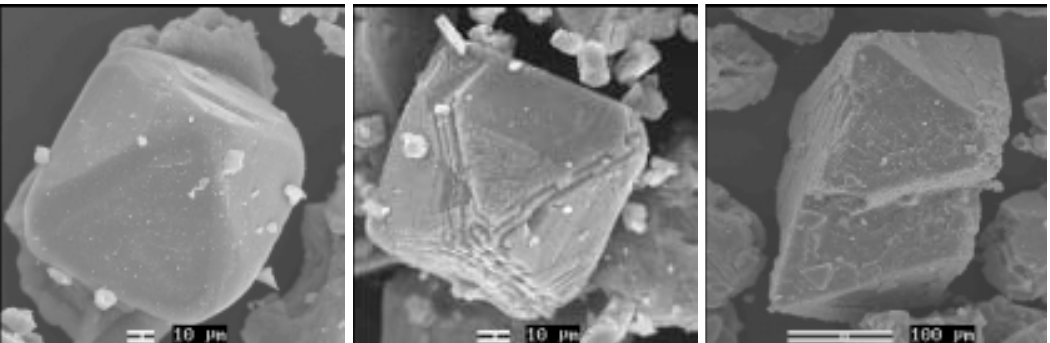
Figura 2. Micrografias obtidas por microscopia eletrônica de varredura de grãos da fração magnética da amostra